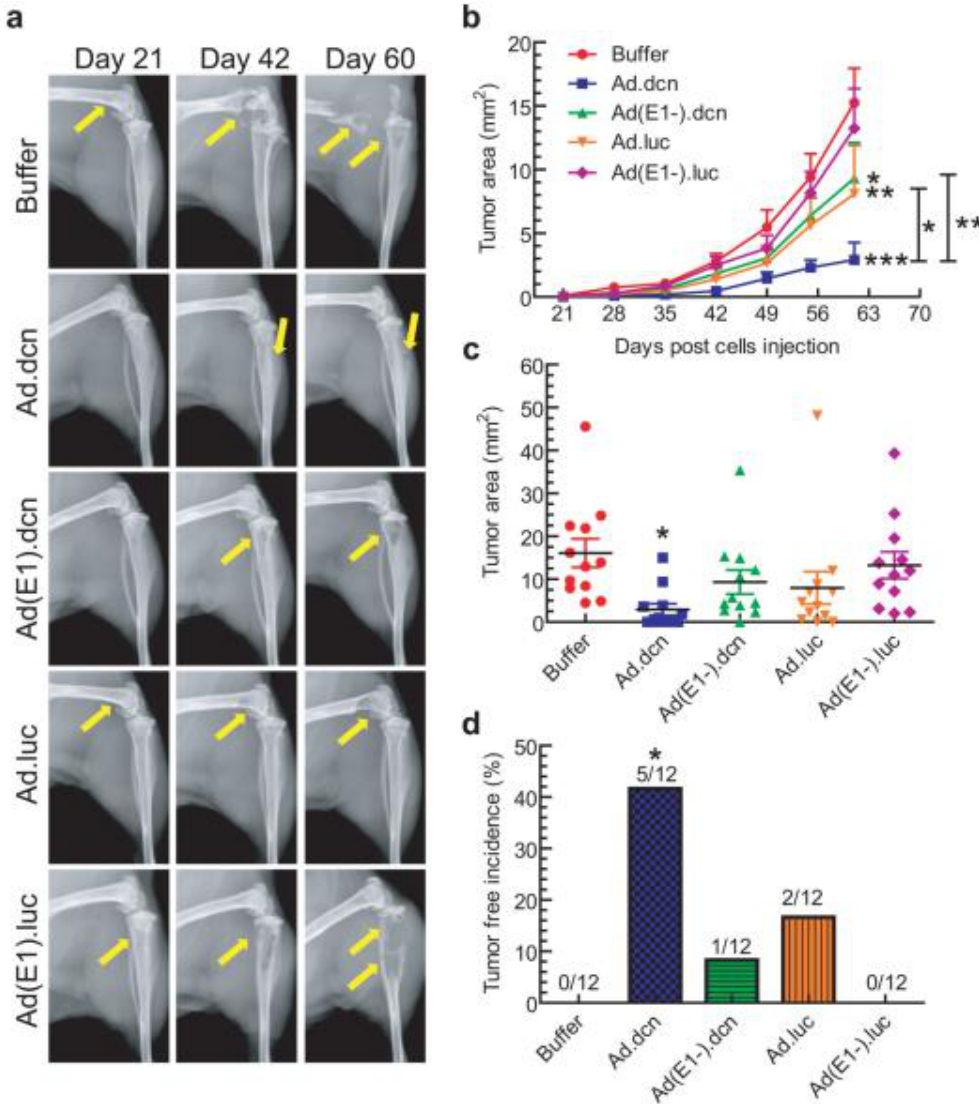
Figure 4. Effect of adenoviral vectors on skeletal tumor progression. ( a ) Representative radiographs of the hind limbs of mice from each treatment group on days 21, 42, and 60 are shown ( n = 12 mice per group). Yellow arrows indicate the sites of osteolytic lesions. ( b ) Skeletal tumor progression was monitored by quantifying the radiographical sizes of lesions in both hind limb bones for the duration of the study. ( c ) Lesion sizes in the hind limb bones on day 60. ( d ) Each treatment group’s incidence of bone metastasis-free mice (i.e., mice without radiographically evident lesions) on day 60. P values for comparisons with the buffer group are shown in ( b – d ), and p values for comparisons between Ad.dcn and Ad.luc and between Ad.dcn and Ad(E1-).dcn are shown in ( b ). * p < 0.05; ** p < 0.01; *** p < 0.001. (Adapted with permission from [163]).